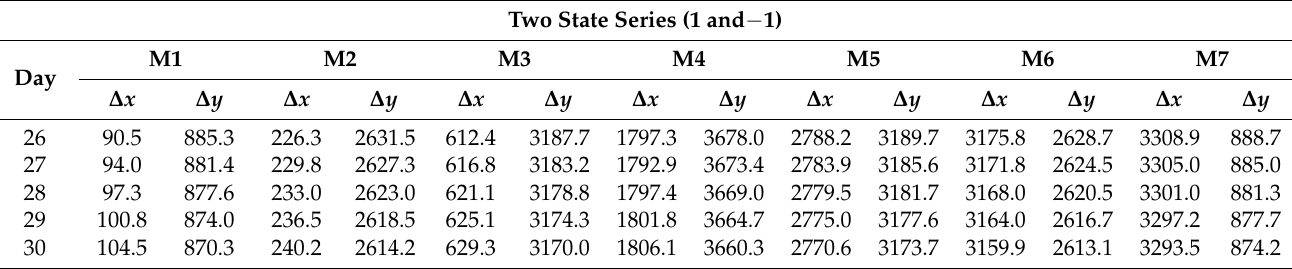
Table 29. Forecasted coordinates of markers (forecasting-validity phase). Two State Series (1 and − 1)